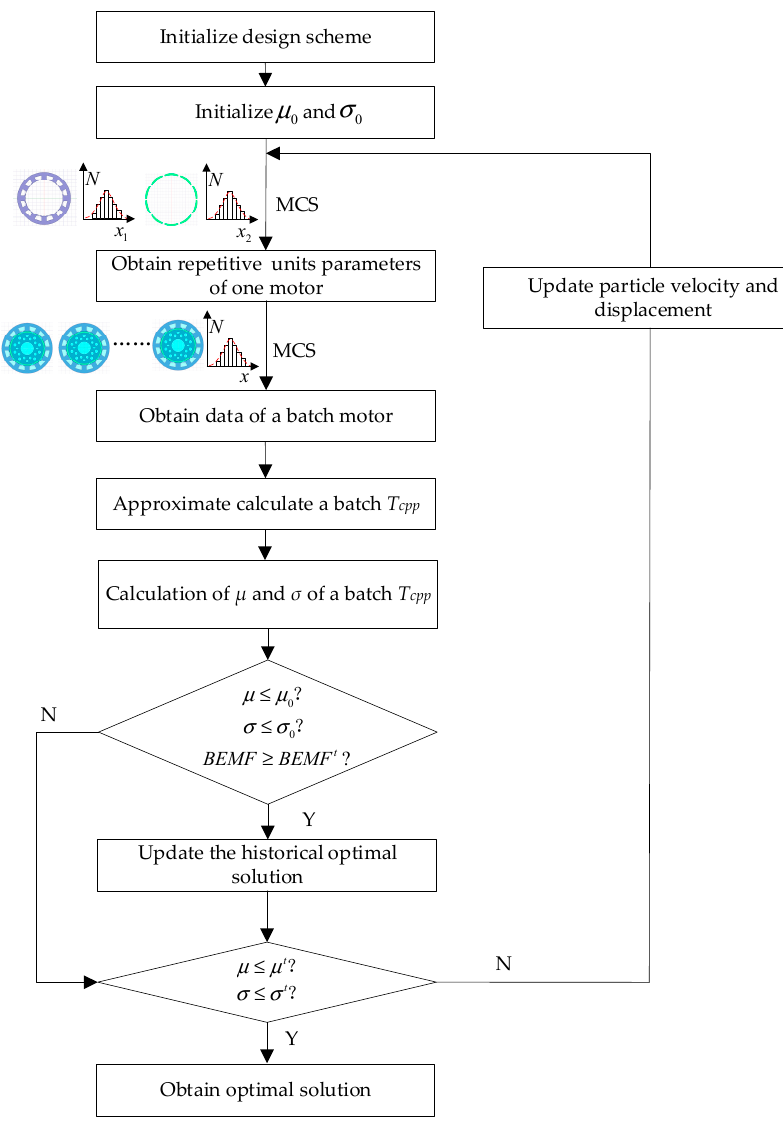
Figure 6. Robust design optimization with repetitive unit